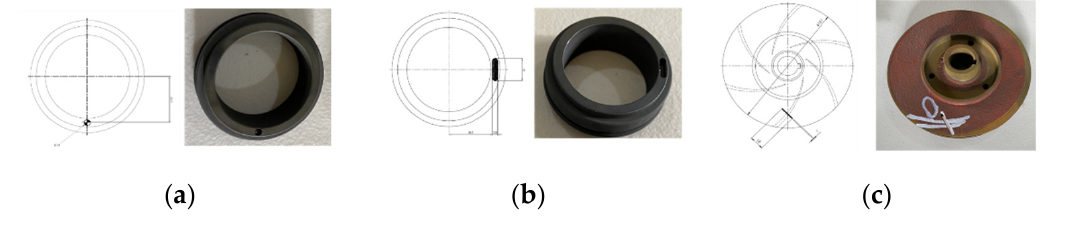
Figure 3. MCP defects: ( a ) MSH, ( b ) MSS, and ( c ) IF. A total of 1200 s of VS were collected from the MCP. All of the VS were digitized using a NI-9234 DAQ. Figure 4 shows the VS obtained from the MCP in NC and a defective